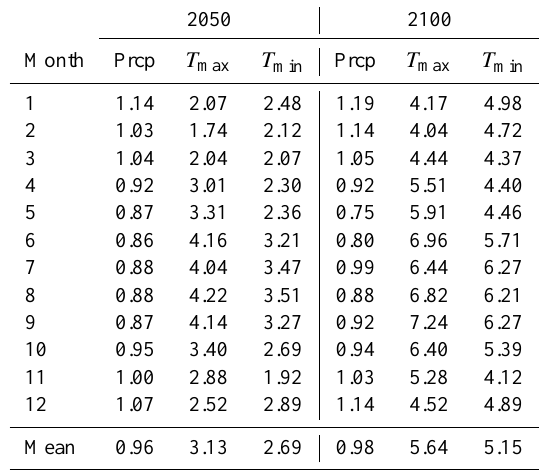
Table 3. Delta perturbations for SRES A2 emissions scenario, for decade centered on 2050 and decade ending in 2100.